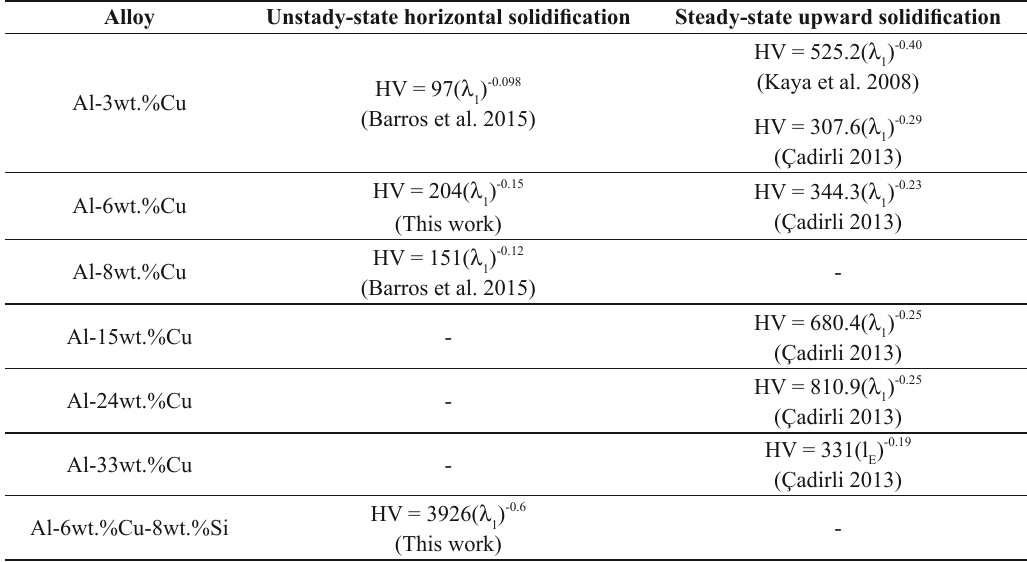
Hall-Petch experimental expressions proposed in this work of microhardness as a function of the primary dendrite arm spacings and comparison with other from the literature for Al-Cu